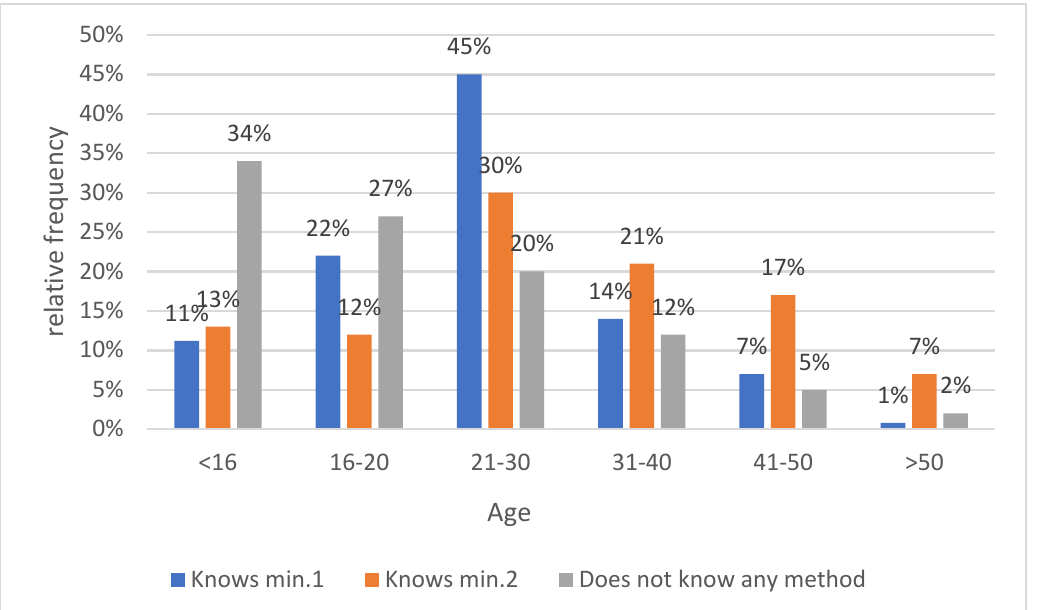
Figure 5. Respondents answers to the question: why did you use an antimalarial drug? Statistically significant differences were found in the age groups 21–30 years old and 31–40 years old with a significance level of p < 0.001. Among the respondents who did not know any alternative method of malaria prevention, statistically significant differences were found for the age group below 16 years old ( p < 0.001) (Figure 6).